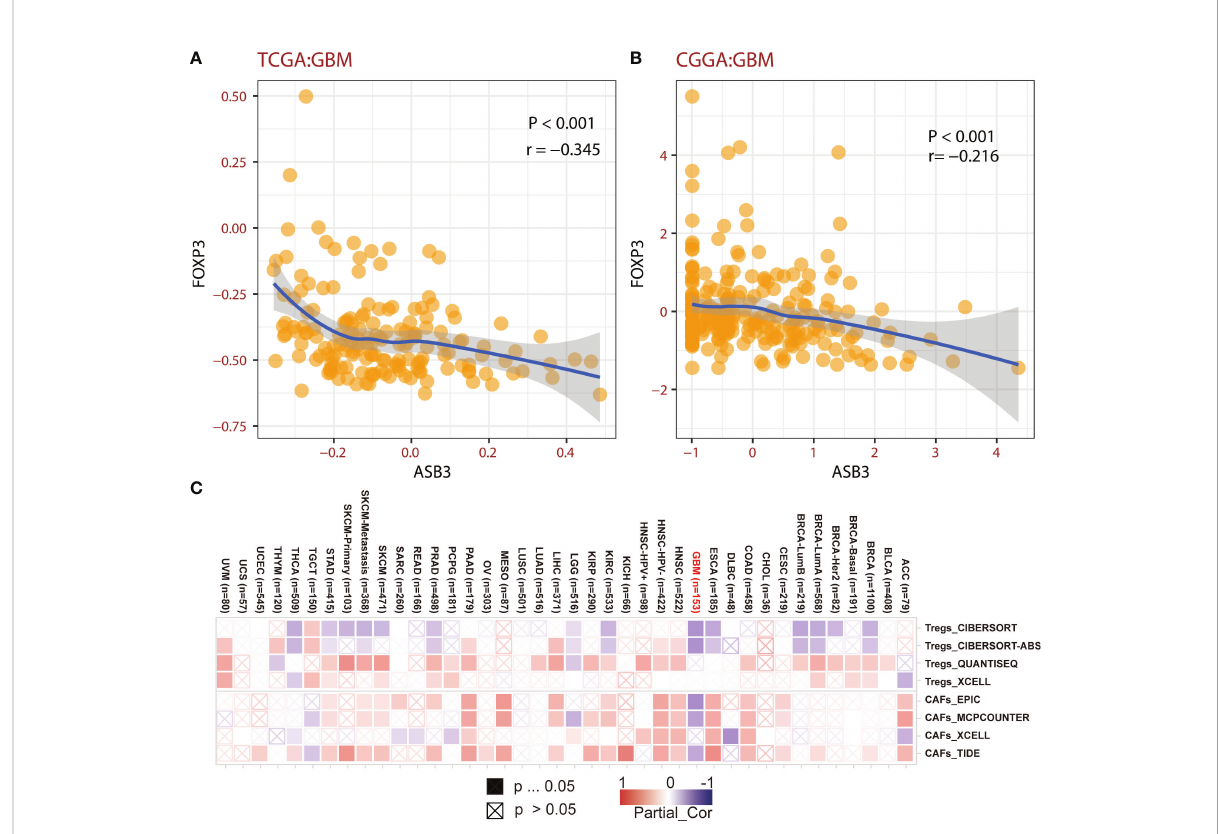
FIGURE 5 The correlation of ASB3 and Tregs. (A) Correlation coef fi cient of ASB3 and FOXP3 in TCGA GBM data. (B) Correlation coef fi cient of ASB3 and FOXP3 in CGGA GBM data. (C) Correlation heatmap of ASB3 and Tregs or CAFs in